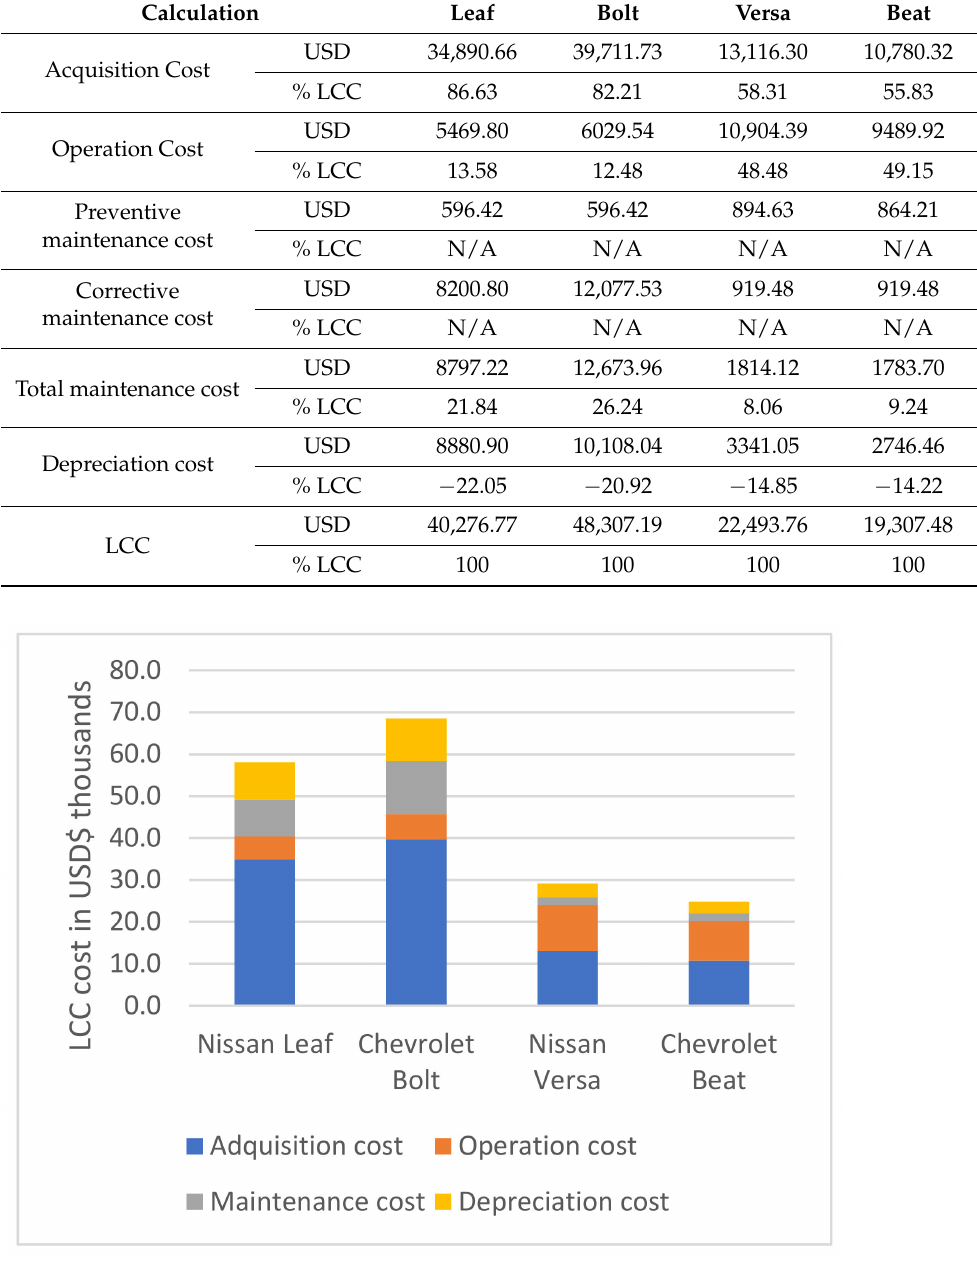
Table 2. LCC results.